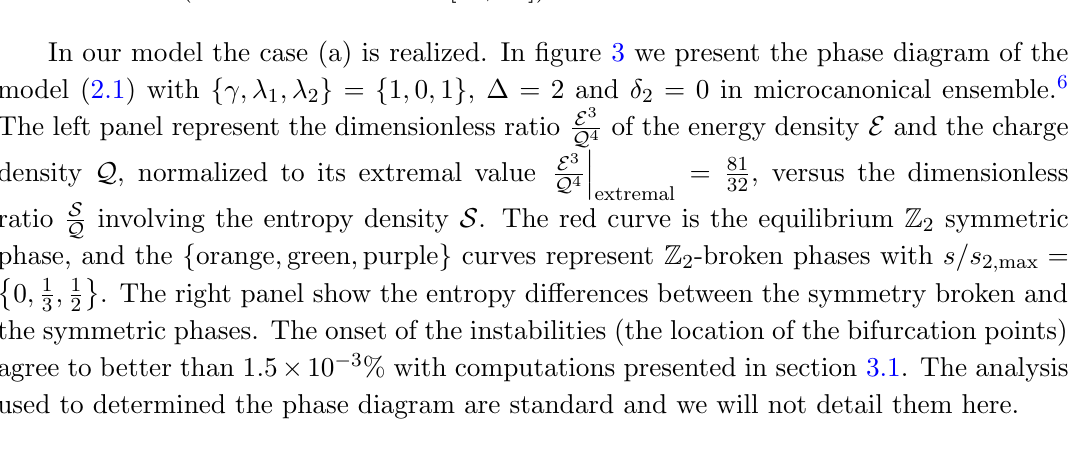
Figure 3 . Phase diagram of the holographic viscoelastic media with spontaneous breaking of Z 2 symmetry due to a dimension (cid:1) = 2 operator. The red curve is f orange ; green ; purple g curves represent Z 2 -broken phases with s=s 2 ; max = panel enhances the entropy di(cid:11)erences between the symmetry broken and the symmetric phases at (cid:12)xed energy density E and the charge density Q